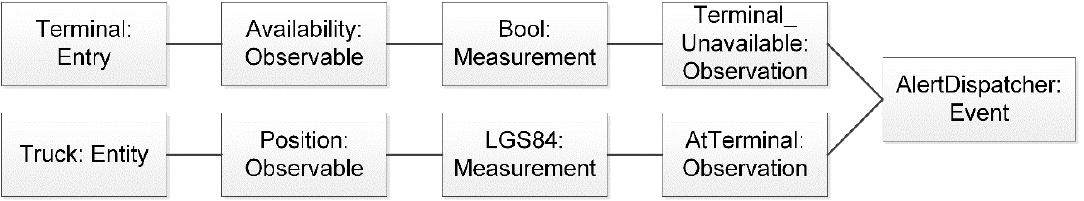
Figure 4. Exception “AlertDispatcher”.